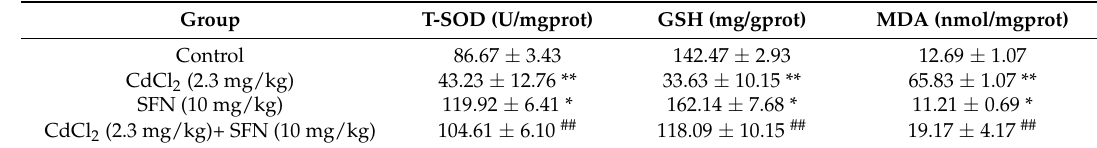
Table 2. Effects of sulforaphane on antioxidant levels following cadmium exposure.